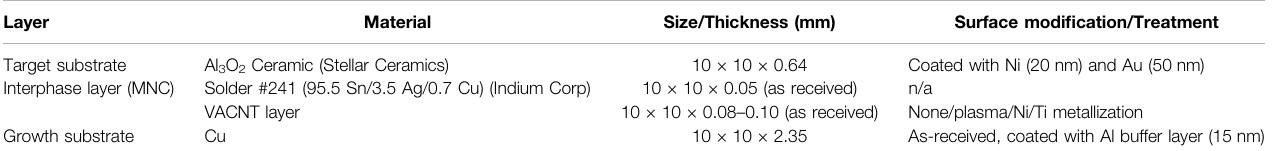
TABLE 1 | Sample preparation materials.